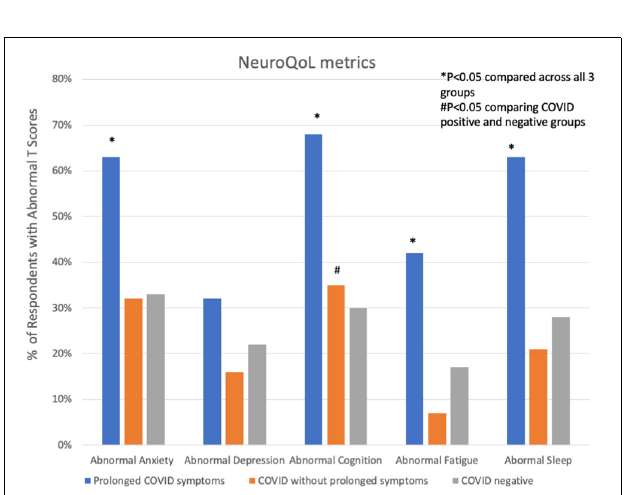
FIGURE 2 | Abnormal NeuroQoL T-scores in subjects with prolonged COVID-19 symptoms, COVID-19 without prolonged symptoms and COVID-19 negative subjects. Abnormal T-scores were defined as: T-score > 55 for anxiety, depression, fatigue, or sleep and < 45 for cognition. * P < 0.05 comparing across all three groups; # P < 0.05 comparing COVID positive to COVID